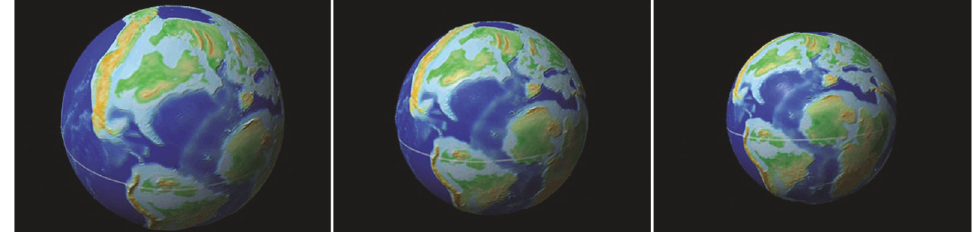
Fig. 3. Example of a non-temporal animation: the placement of continents in the late Cretaceous (about 80 million years ago)